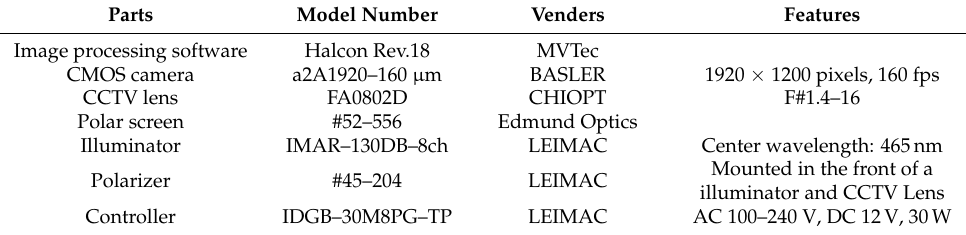
Table 3. Hardware specifications.